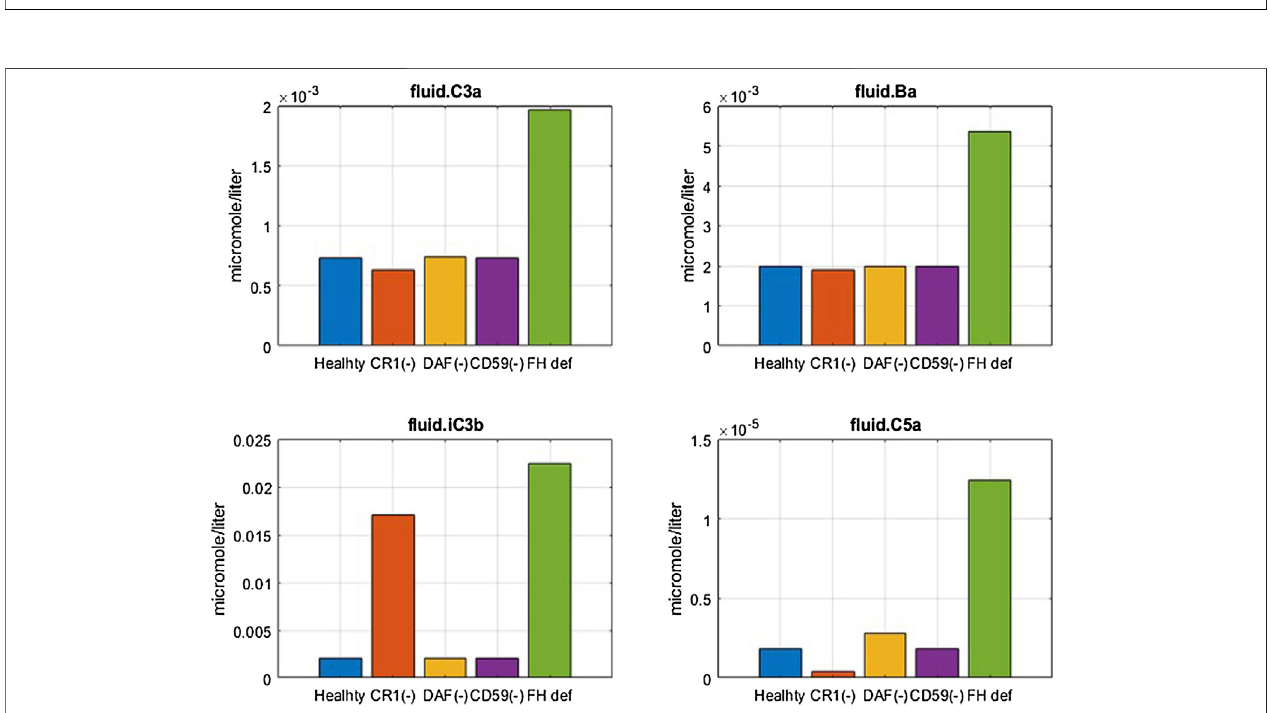
FIGURE7| Effectof99%reductionincellsurfaceregulators,CR1,DAF,andCD59,and50%reductionin fl uidphaseregulatorFHoncomplementfragmentsC3a, Ba, iC3b, and C5a.